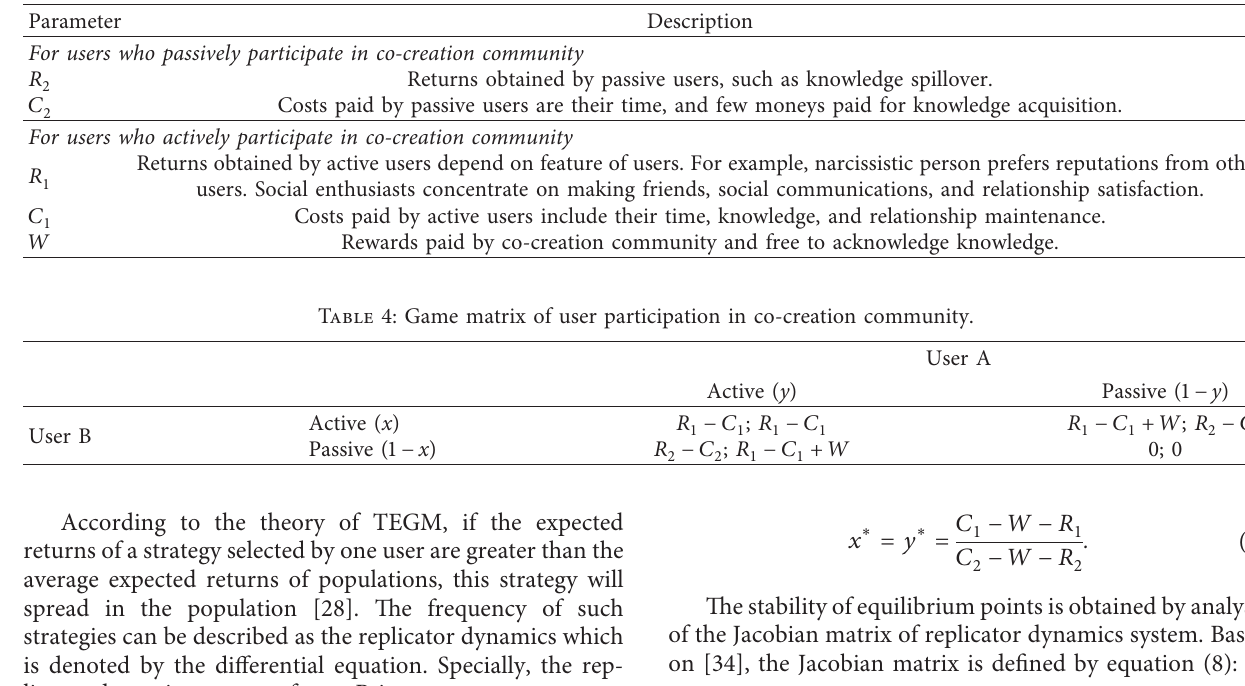
Table 3: Parameter setting of TEGM.